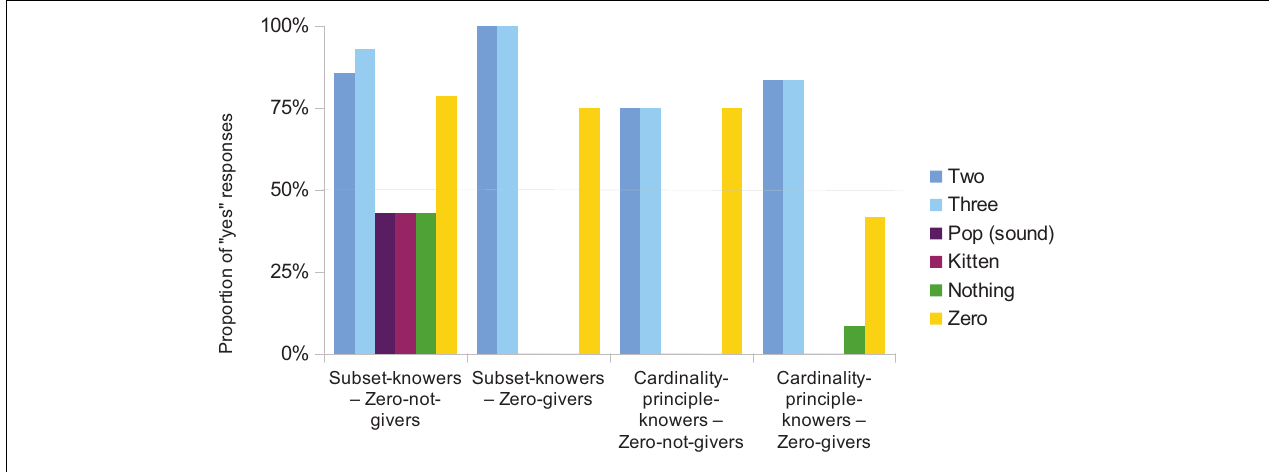
FIGURE 3 | Proportion of “yes” responses in the is-it-a-number task at the beginning of the session. Horizontal line at 50% shows the random choice level.